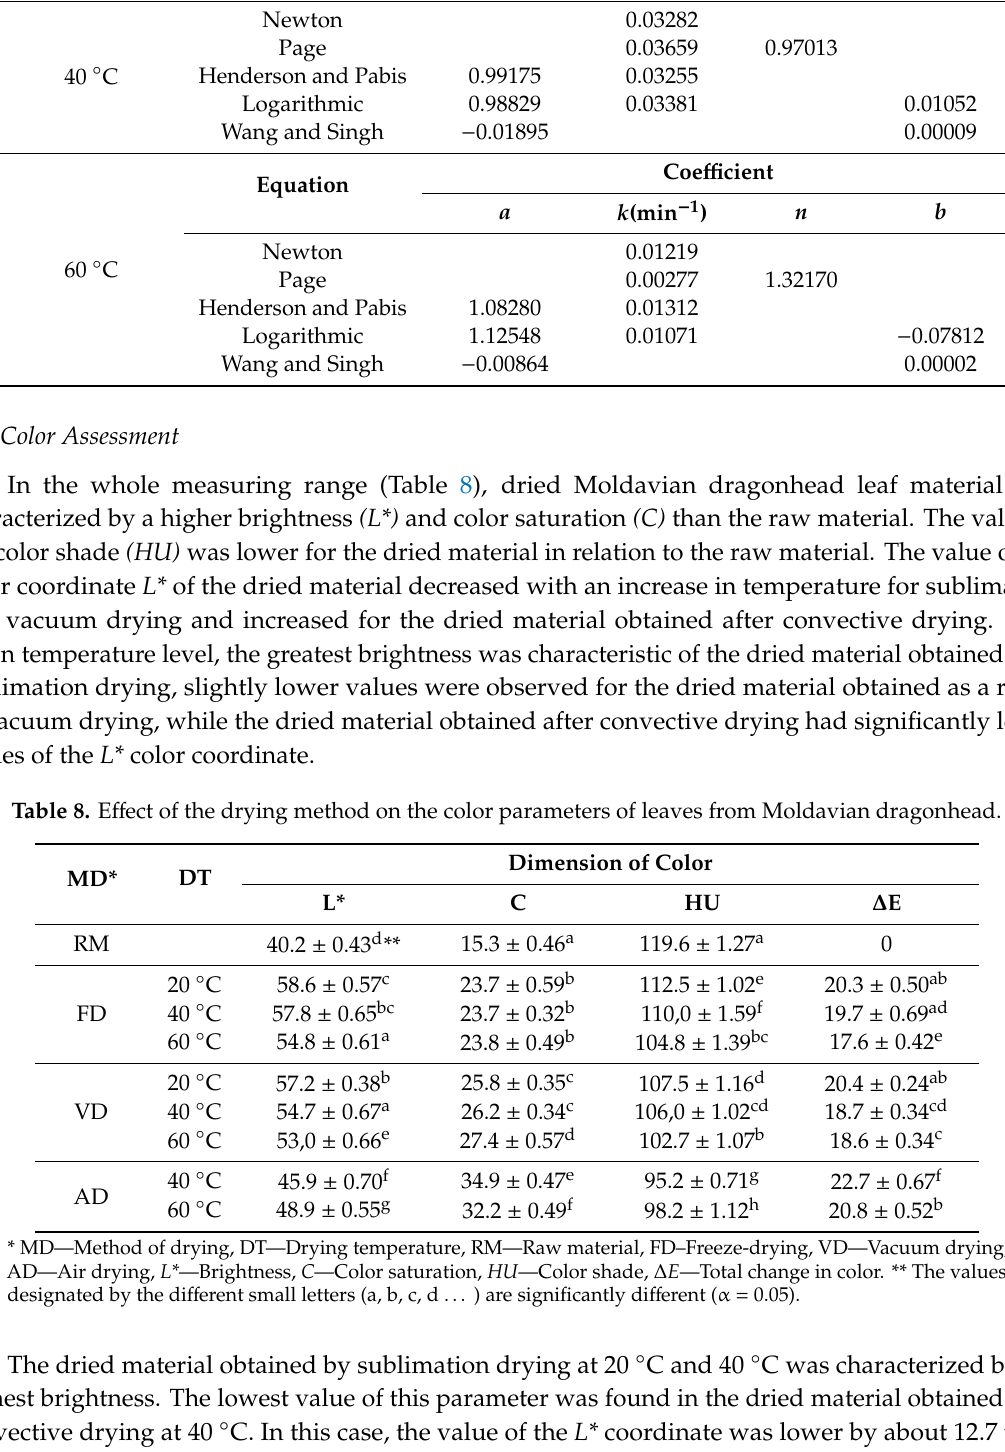
Table 7. Values in the models describing the air drying of Moldavian dragonhead. Temperature